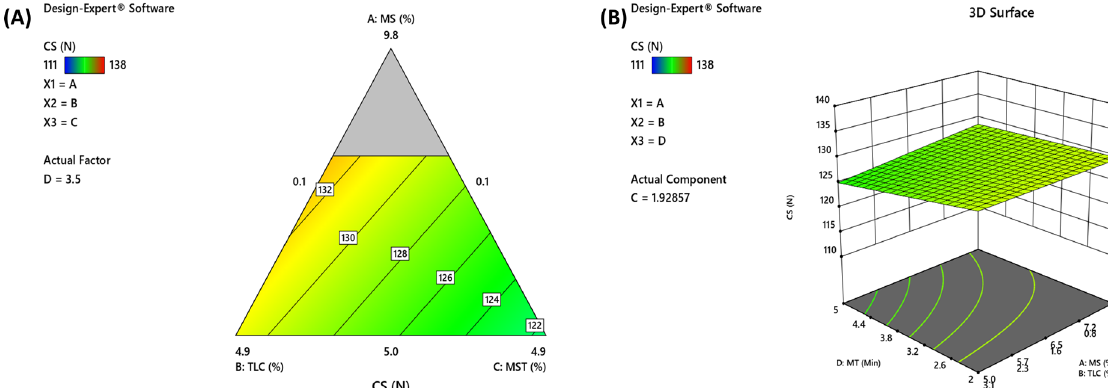
FIGURE 3 - (A) Contour plot and (B) 3D Surface Plot for response